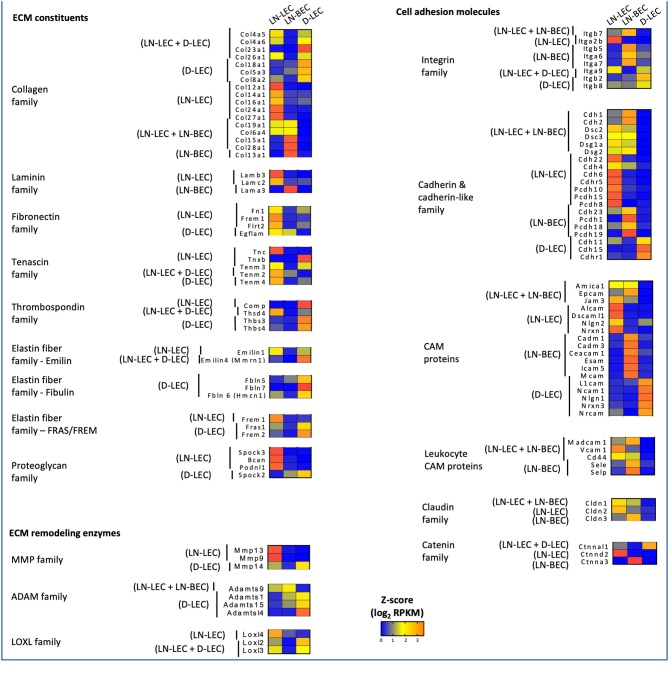
5X-DEG in all five subsets expressed distinct and shared members of the ECM constituents, remodeling enzymes, cell adhesion molecules. Heatmap analysis based on Z-score values of average log2 FPKM for replicates in each cell type (details in Methods).